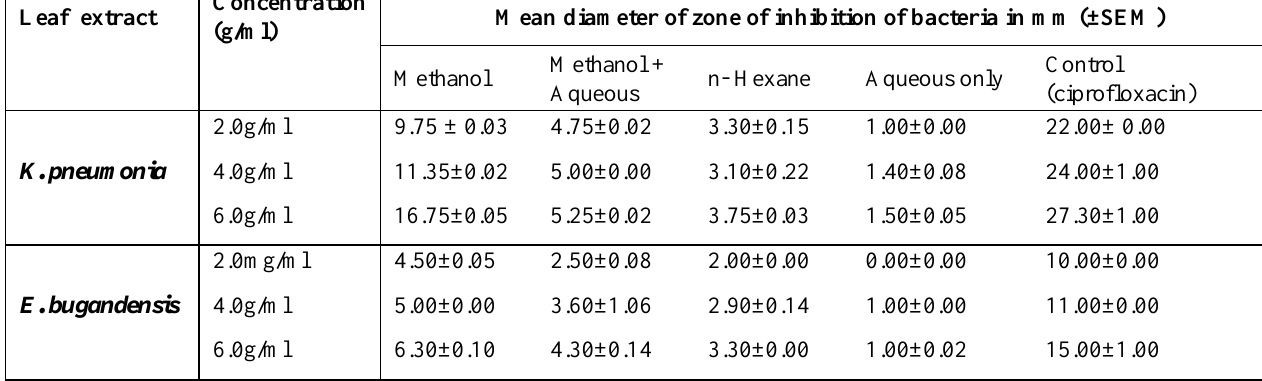
Table 2 : Antibacterial activities of scent leaf extract on K. pneumonia and E. bugandensis (AdM2). Leaf